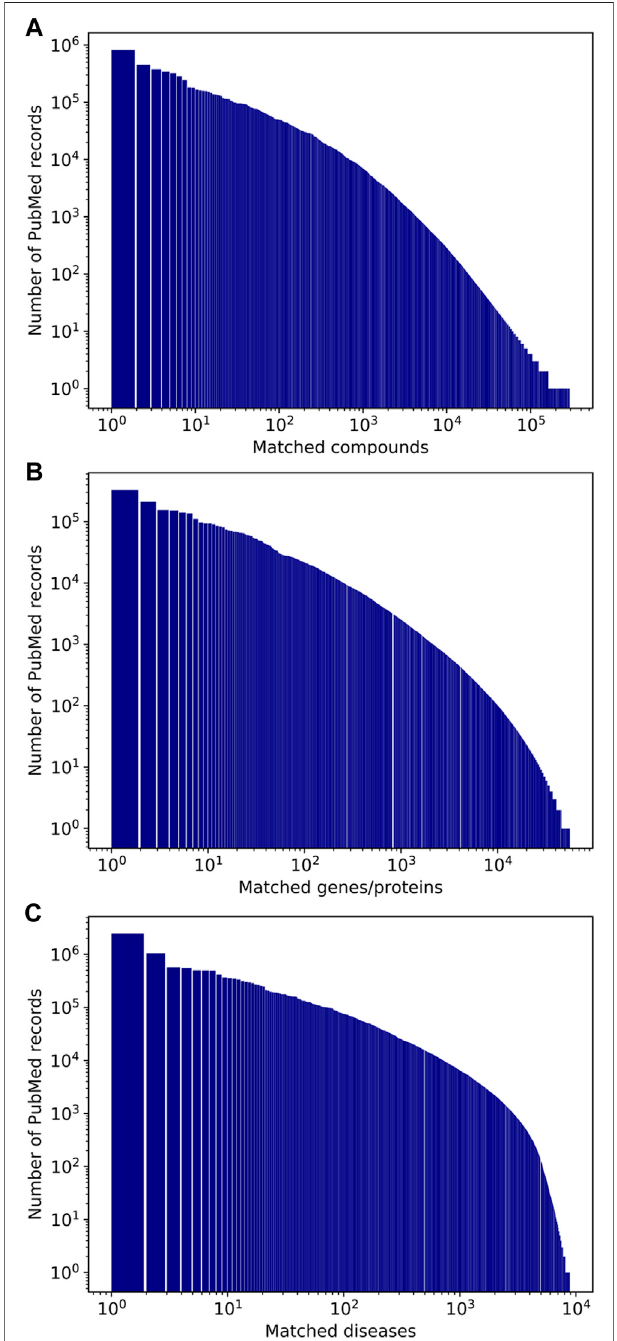
FIGURE 5 | Number of occurrences of compounds (A), genes/proteins (B), and diseases (C) in PubMed records.